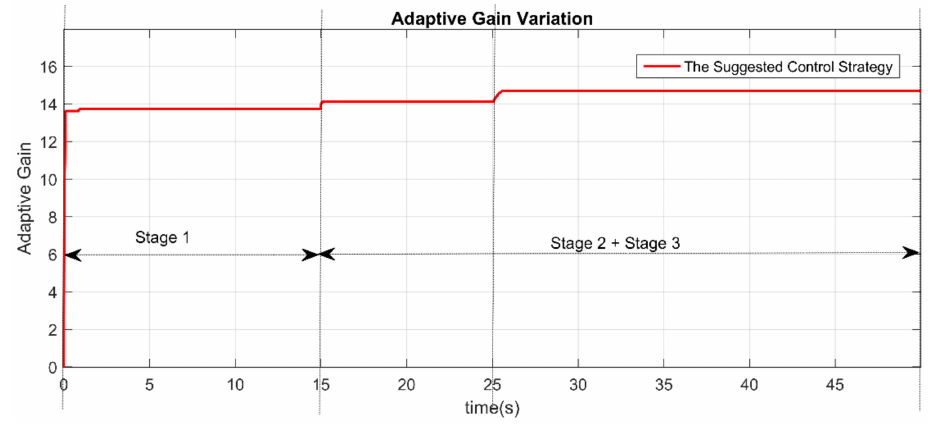
Figure 6. Time history of adaptive